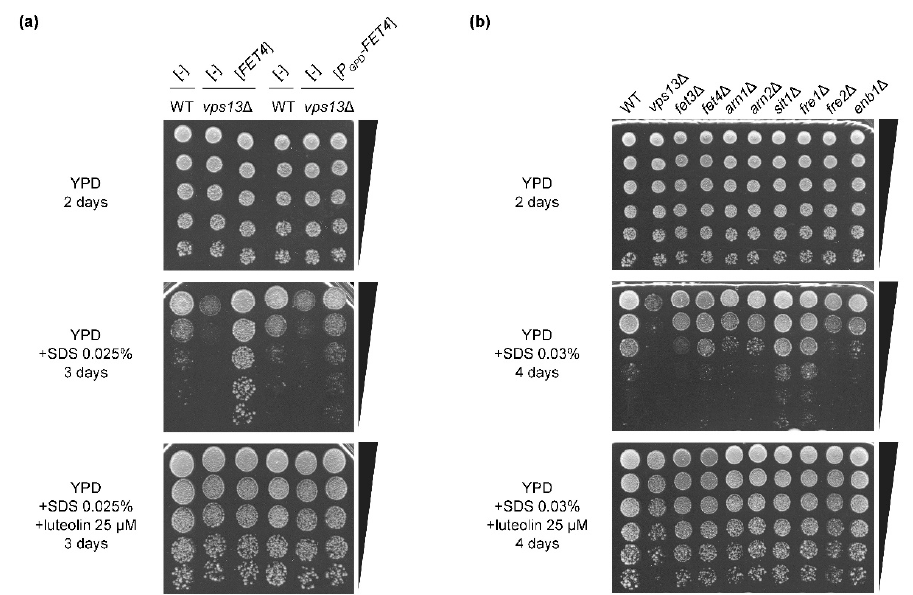
Figure 5. Genetic link between iron transport, luteolin, and SDS hypersensitivity. ( a ) The vps13 Δ growth defect on SDS media is suppressed by FET4 overexpression and by luteolin. Growth of vps13 Δ strain bearing a plasmid expressing FET4 from native or GPD promoter, or empty vector, was compared with respective controls by drop test on YPD, YPD + SDS 0.025%, and YPD + SDS 0.025% + luteolin 25 µ M plates. Images were taken after 2 or 3 days of incubation. ( b ) Mutants defective in iron transport are hypersensitive to SDS; this phenotype is suppressed by luteolin. Growth of fet3 ∆ , fet4 ∆ , arn1 ∆ , arn2 ∆ , sit1 ∆ , fre1 ∆ , fre2 ∆ , and enb1 ∆ strains on YPD, YPD + SDS 0.03%, and YPD + SDS 0.03% + luteolin 25 µ M plates was compared with wild-type and vps13 ∆ controls by drop test. Images were taken after 2 or 4 days of incubation.